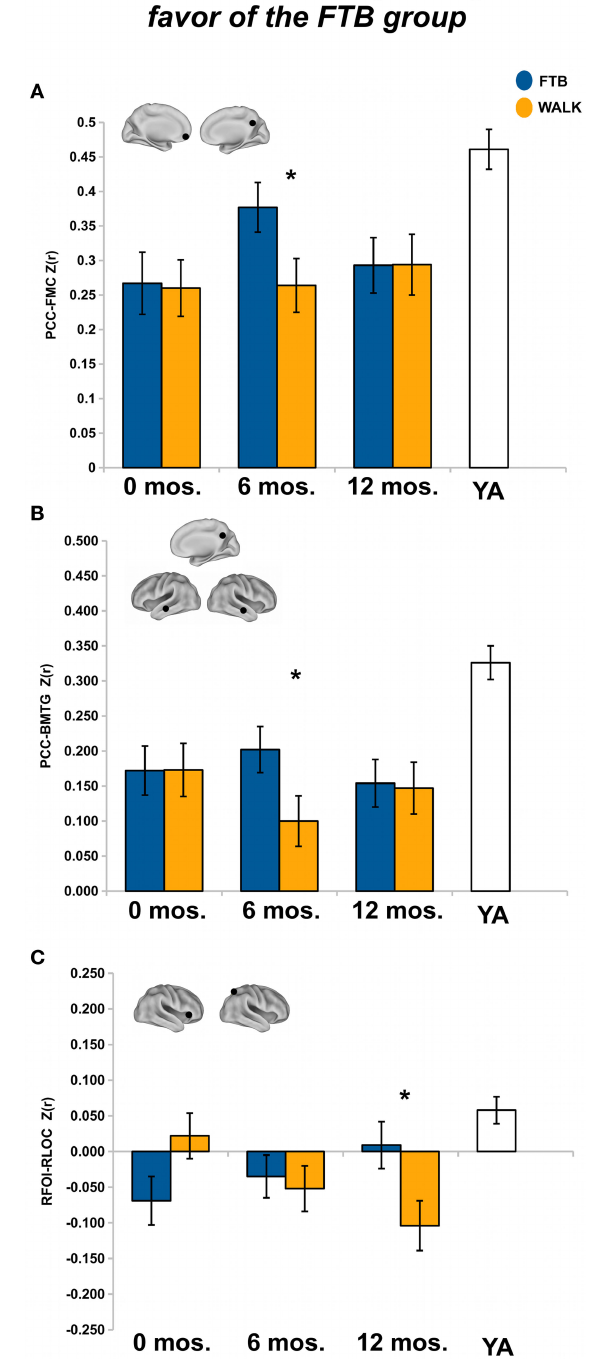
FIguRe 2 | Significant effects in favor of the FTB group, in regions reflecting age-related network disruption, in the DMN. (A, B) and the FP network (c) , are visualized by plotting marginal group means from the analysis at the corresponding time point (error bars represent 1 ± standard error of the marginal mean); * p < 0.05. Refer to Table 3 for anatomical description and MNI coordinates of ROIs represented by black circles. For all brains, R = R and L =